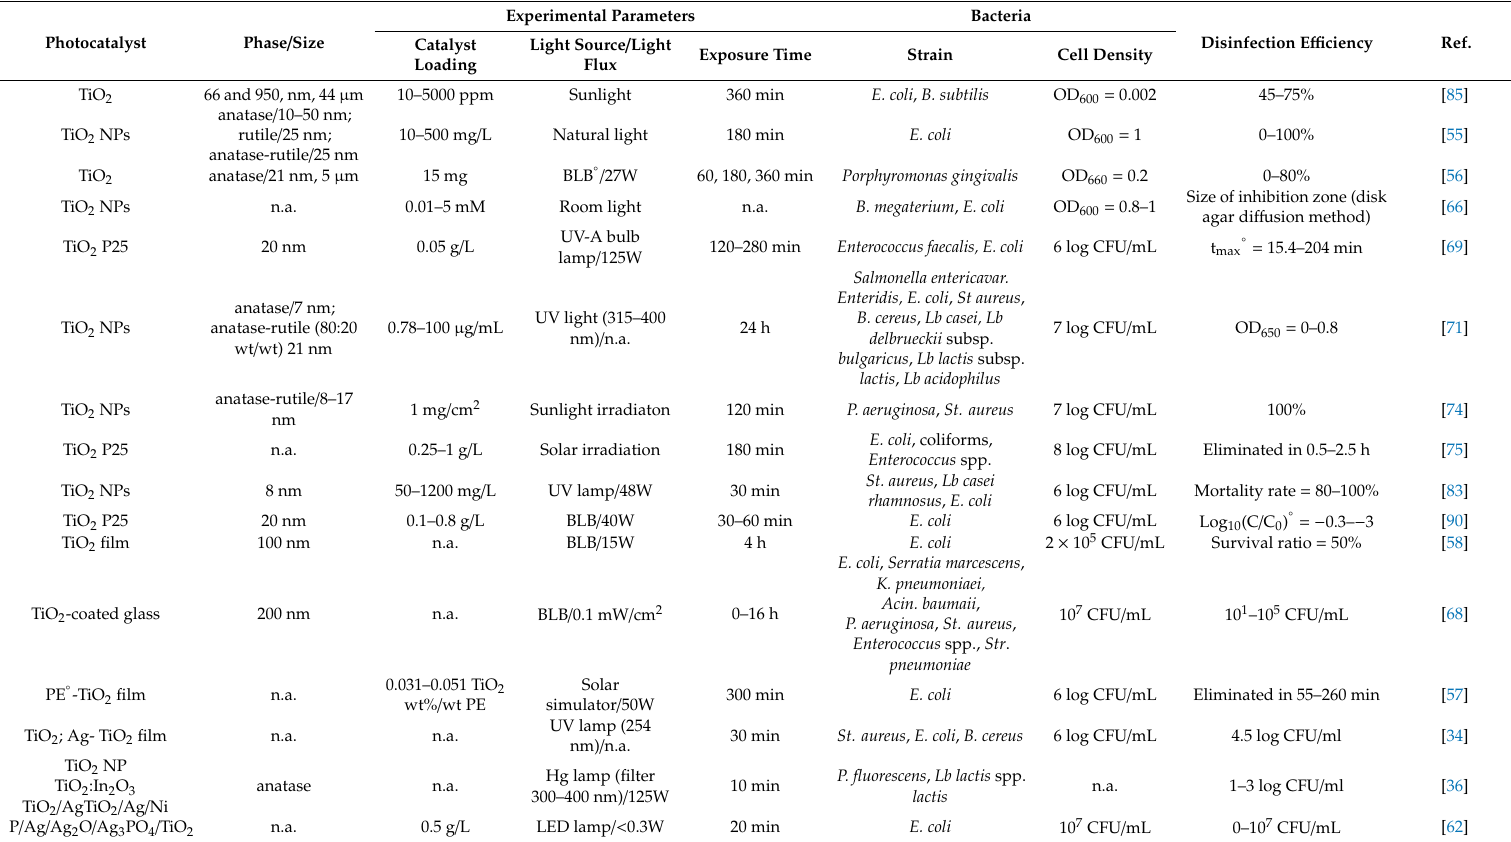
Table 1. Summary of the experimental conditions reported in the literature for TiO 2 -based nanomaterials photocatalyzed bacterial